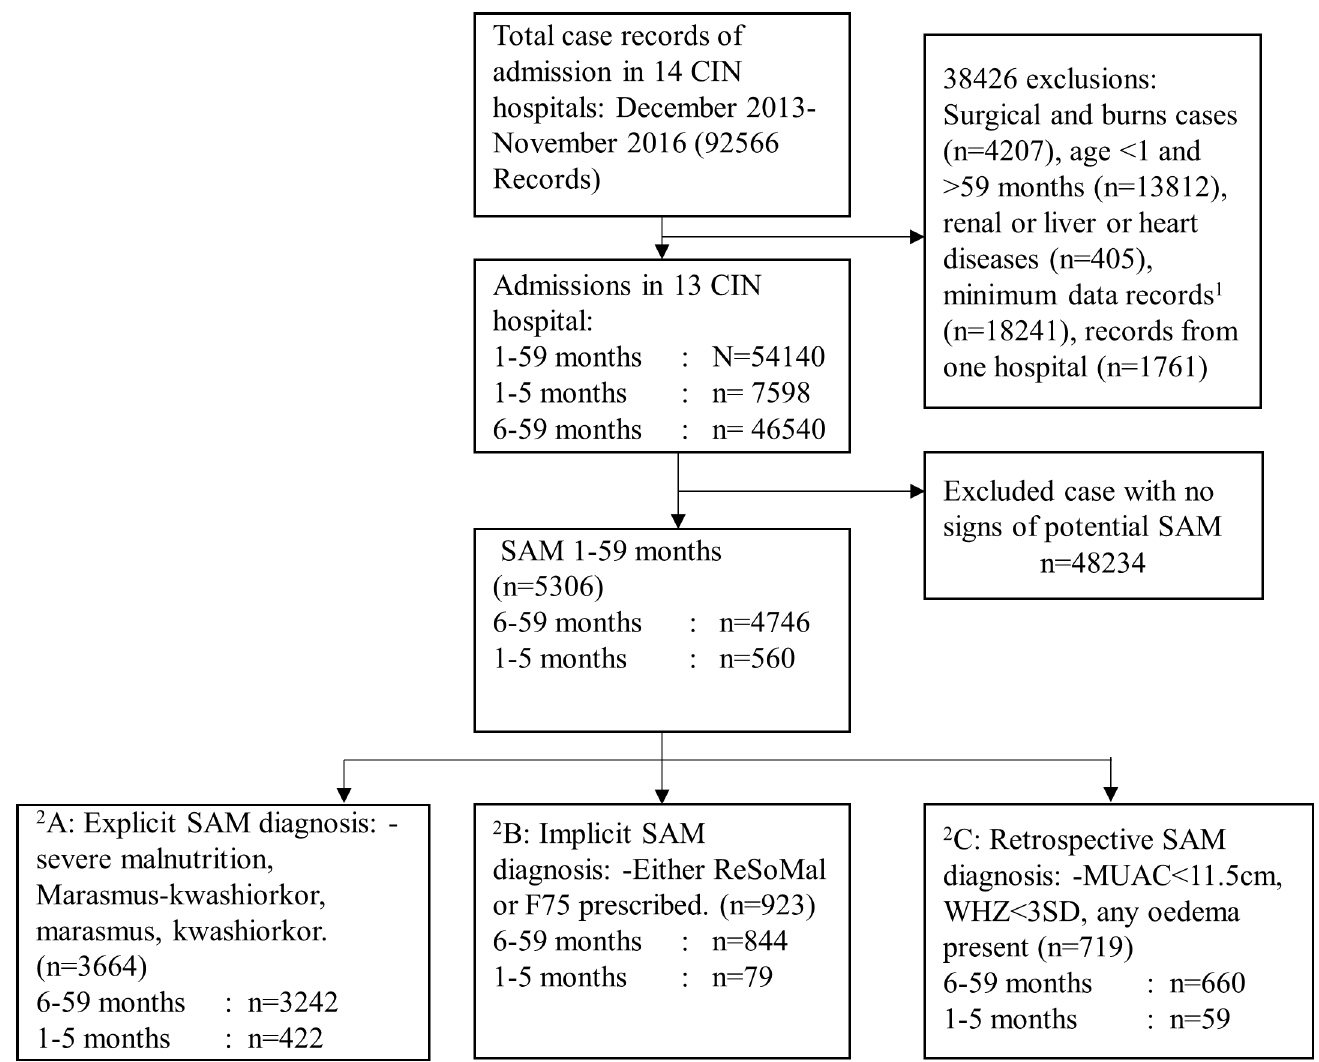
Fig 1. Flowchart of selection and classification of potential severe acute malnutrition cases in the CIN hospitals. CIN- Clinical Information Network, SAM: -Severe acute malnutrition, 1 Minimum data records–data entry restricted to biomedical and outcome data that is required by the national reporting system 2 Groups A, B and C are mutually